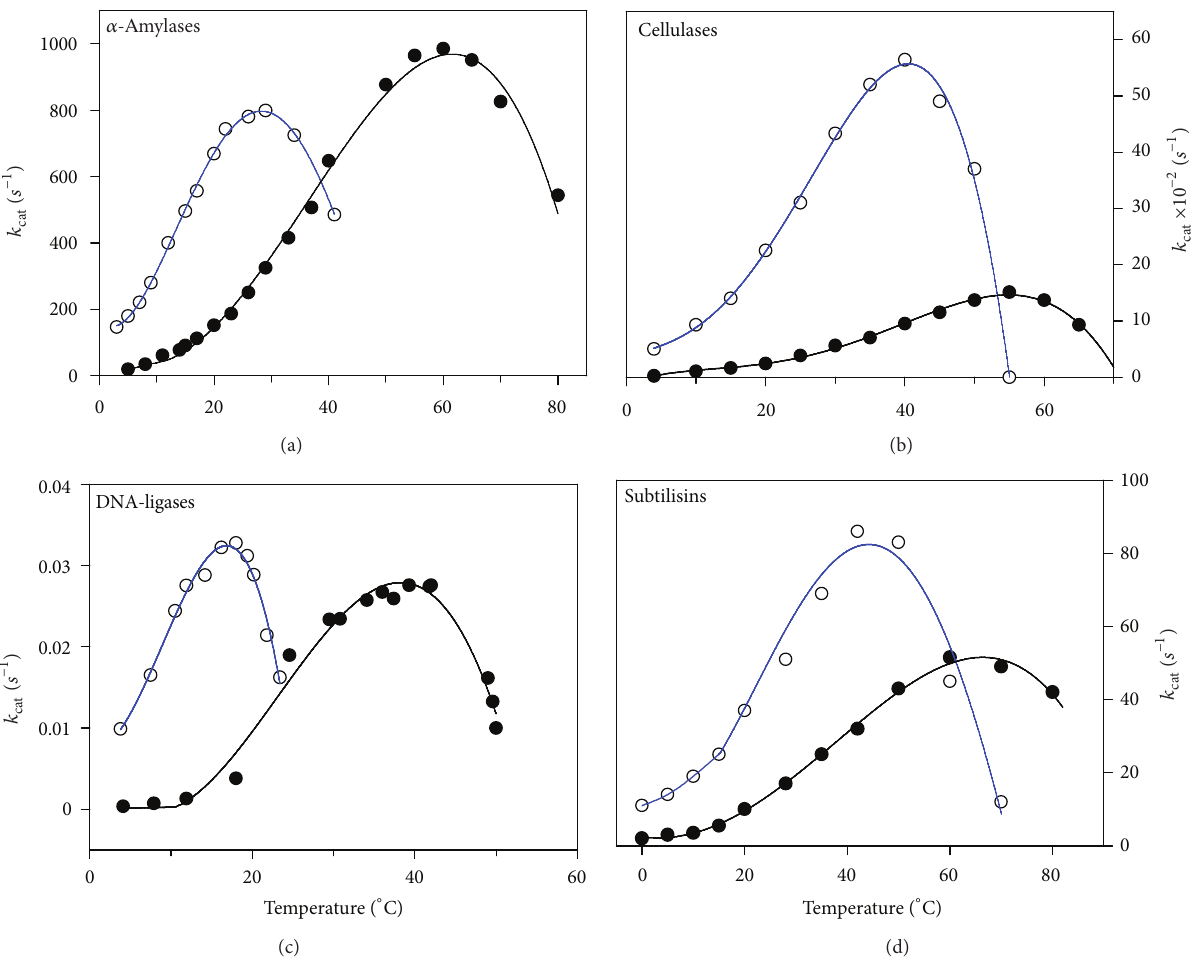
F 4: Temperature dependence of activity. e activity of psychrophilic (open symbols, blue lines) and mesophilic (closed symbols) enzymes recorded at various temperatures illustrates the main properties of cold-adapted enzymes: cold activity and heat lability. Adapted from [32,